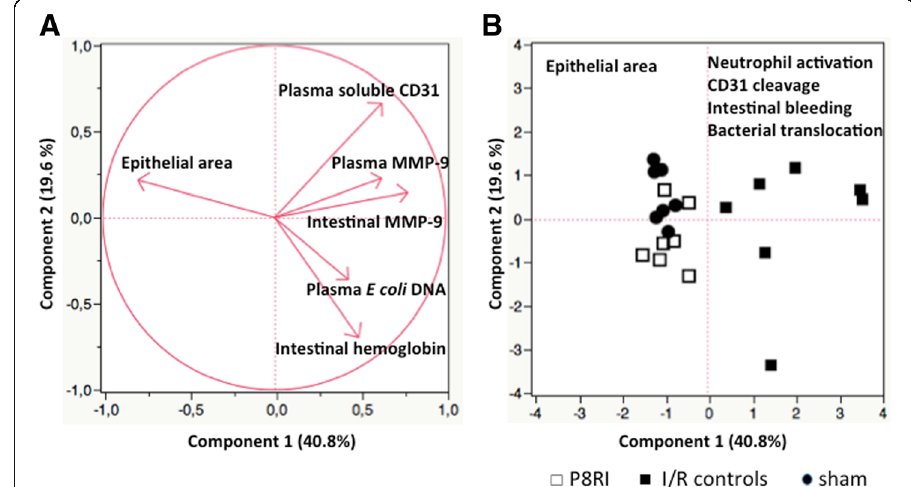
Fig. 5 Role of CD31 in neutrophil activation and intestinal injury after acute mesenteric ischemia. a Principal component analysis showed positive correlations between intestinal MMP-9, plasma MMP-9, intestinal luminal hemoglobin, plasma E. coli DNA, and the shedding of CD31 into plasma in all groups. Conversely, epithelial area was strongly negatively correlated to these parameters. b Principal component analysis identified a clustering of the P8RI and sham groups, widely separated from I/R controls. MMP-9: matrix